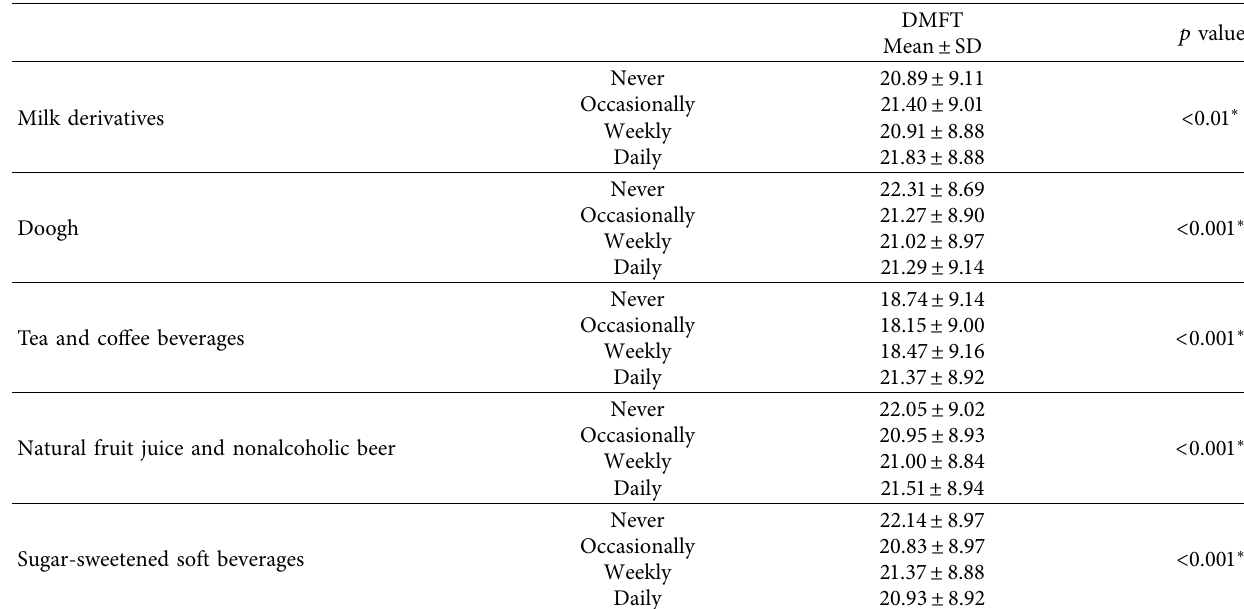
Table 2: DMFT index by beverage consumption frequencies.